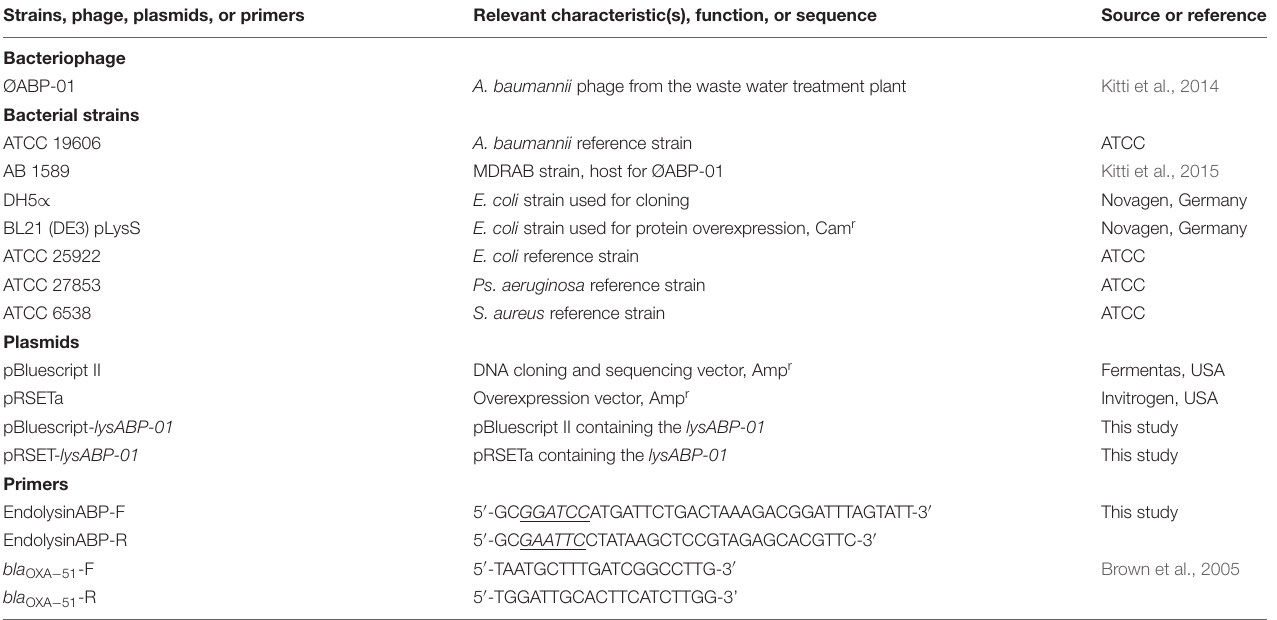
TABLE 1 | Bacteriophage, bacterial strains, plasmids and primers used in this study. Strains, phage, plasmids, or primers Relevant characteristic(s), function, or sequence